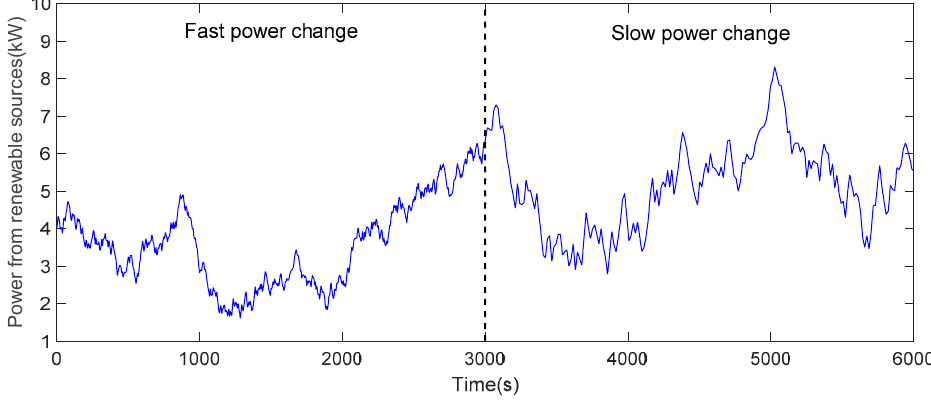
Figure 16. Power from renewable sources.